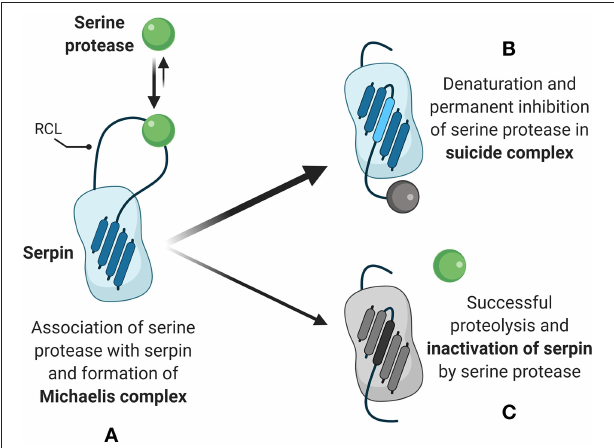
FIGURE 2 | Serpin-dependent mechanism of protease inhibition. (A) Natively folded serpins present a reactive center loop (RCL) which acts as a bait for interaction with active serine proteases. Upon association, initiation of proteolytic activity by the protease triggers the formation of a Michaelis complex and covalent bonding of the serpin with the protease. (B) The primary outcome of Michaelis complex formation is reconfiguration of the serpin, with the RCL inserting as the third of five strands in the core beta sheet and permanent denaturation of the target serine protease. (C) The secondary and less frequent outcome is completion of proteolytic activity and dissociation of the active serine protease, while the RCL continues to insert as the third of five strands in the serpin core beta